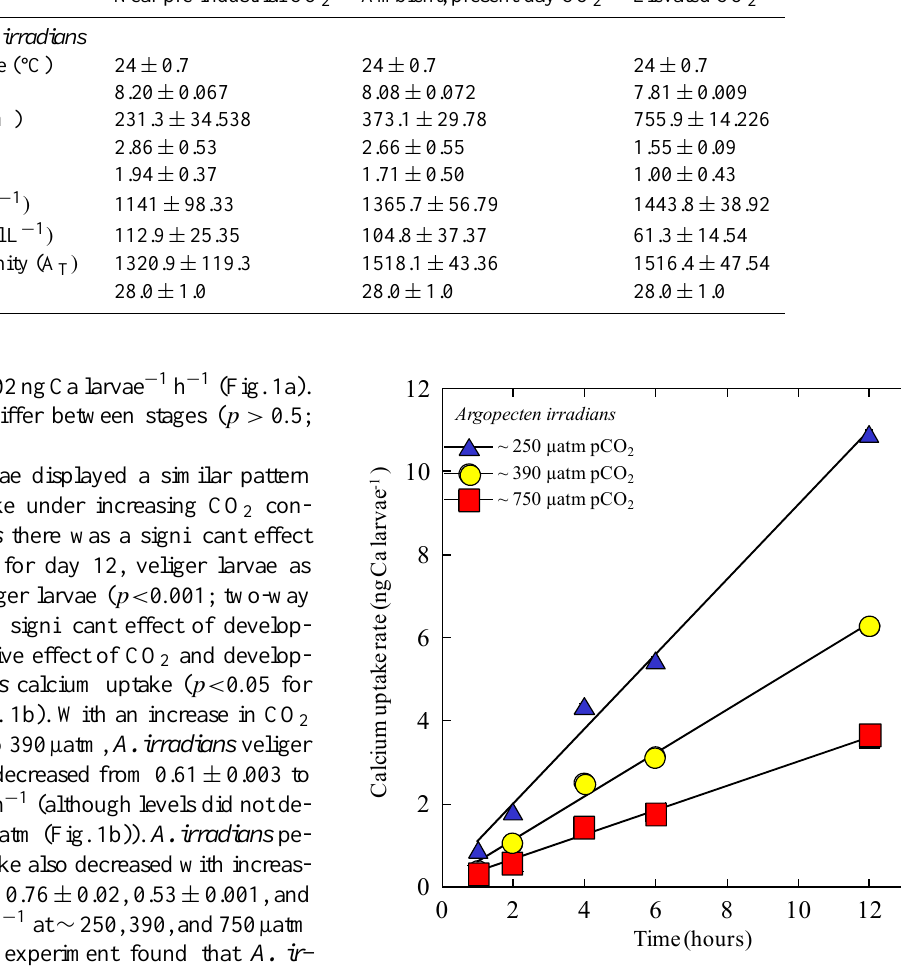
Table 6. Temperature, pH, carbonate chemistry, total alkalinity, and salinity (±1SD) during the three-level carbon dioxide experiments for Argopecten irradians larvae growth before deployment in the estuary for juvenile growth. Parameter Near pre-industrial CO 2 Ambient, present-day CO 2 Elevated CO 2 Argopecten irradians